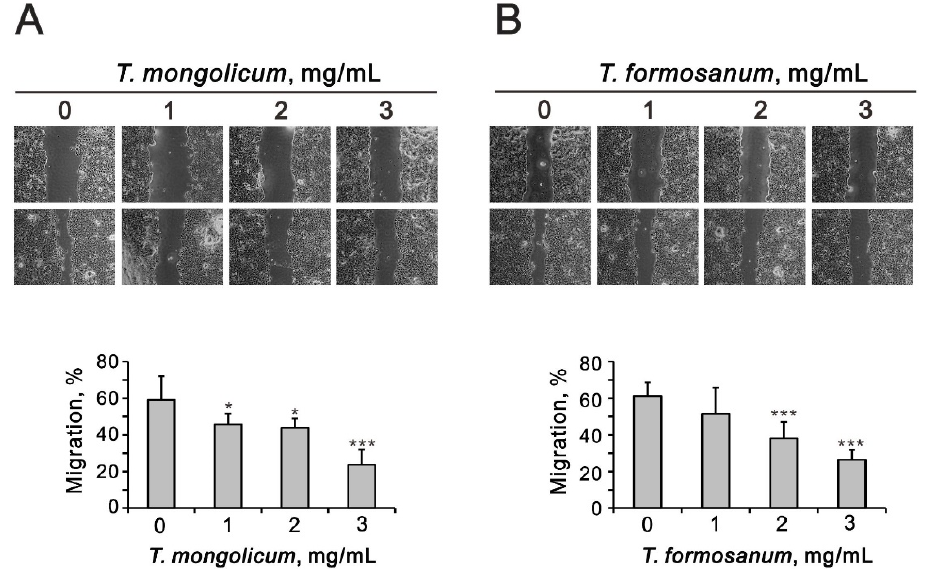
Figure 5. Effect of T. mongolicum and T. formosanum on MDA-MB-231 cell migration. MDA-MB-231 cells were treated with the indicated concentrations of ( A ) T. mongolicum or ( B ) T. formosanum . After 20 h, the cell migration was measured. The results are representative of two independent experiments. Bars depict the mean ±SD. * p < 0.05, *** p < 0.001.